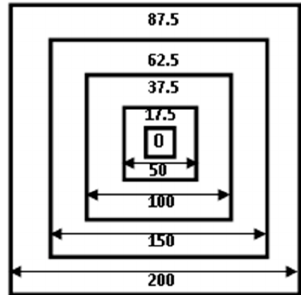
Figure 6. Five square domains surrounding the selected city (the center is denoted by 0). Dimension of the inner domain is 20 × 20 km. This configuration is used to calculate the AOD at distances from the center, shown by the numbers in the upper half of the figure. The spatial gradient of AOD shown in Figure 11 obtained from measurements at these distances (averages of AOD from stripes between successive